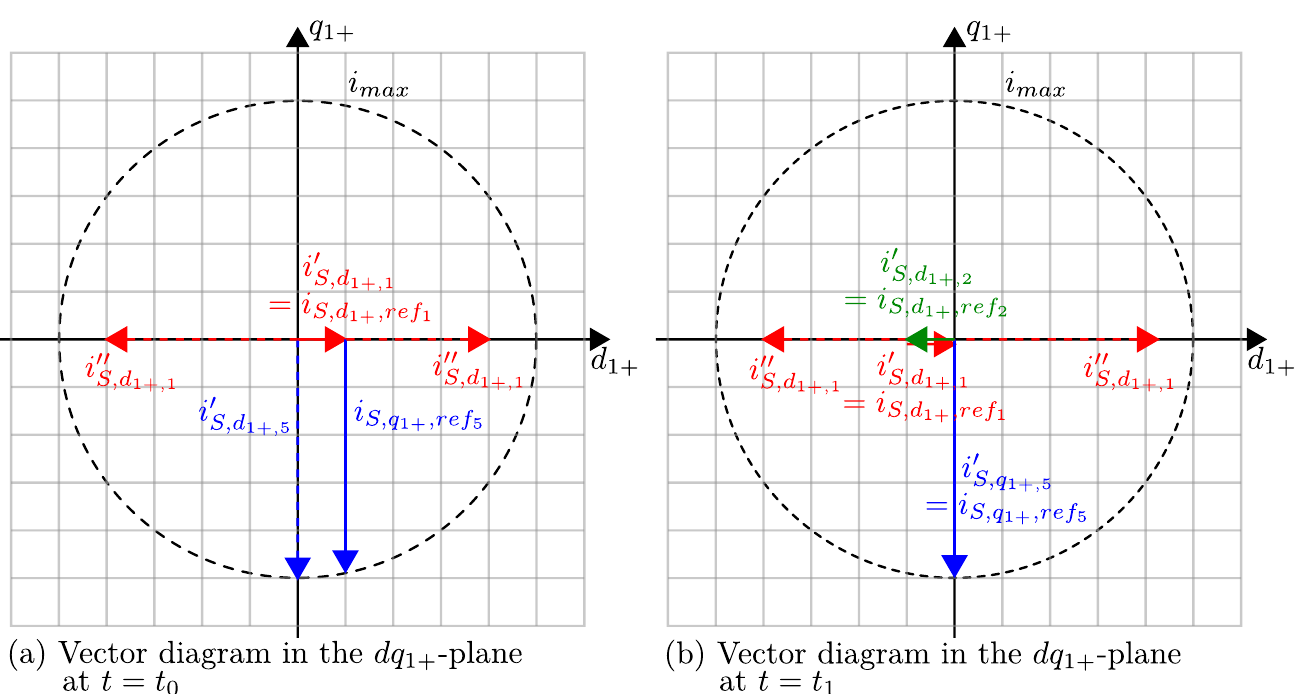
Figure 9. Dynamic prioritization during active functions F 1 , FCR, F 2 , state of charge (SoC)-Management, F 5 , Static Voltage